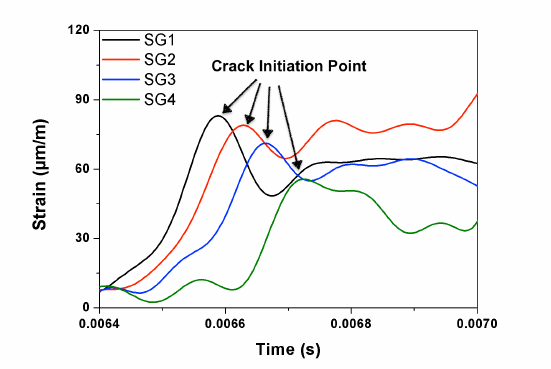
Figure 5. Typical strain-history curves of a PA specimen recorded in SG1–SG4 (loading rate: 2.66 m/s).